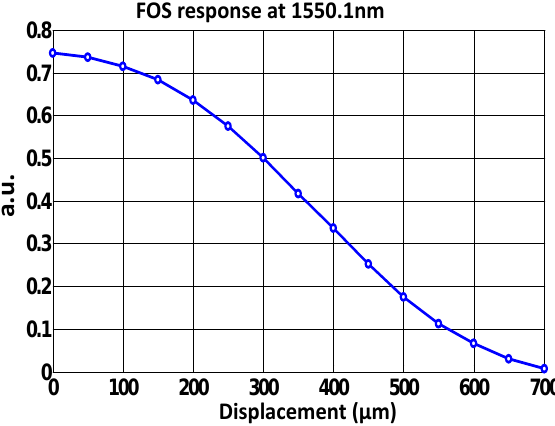
Figure 4. Calibration curve of the sensor loss modulation H for the taper-based displacement